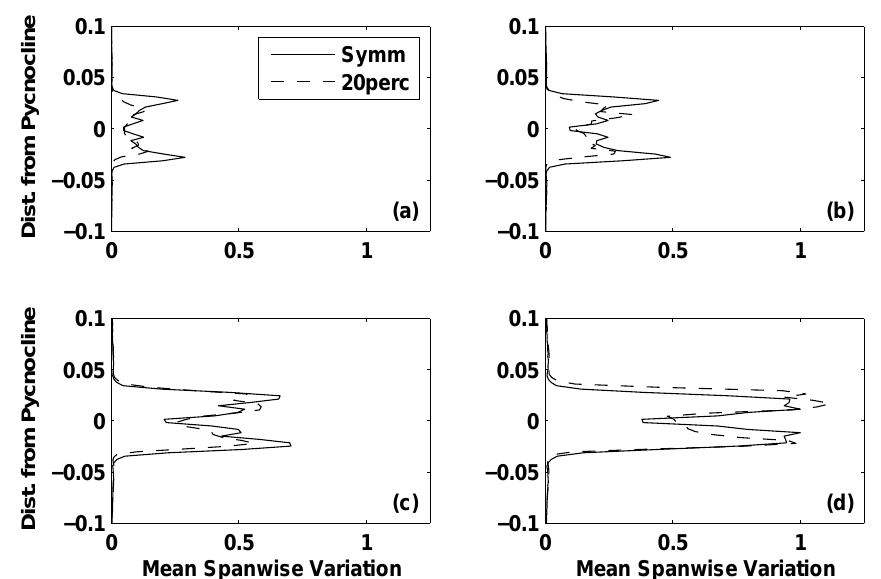
Fig. 10. Plot of the streamwise average of the standard deviation in the spanwise direction of the kinetic energy at t = { 33 . 75s (a) , 35s (b) , 36.25 (c) , 37.5s (d) } . The z-axis has been shifted for the asymmetric case so that both pycnocline centres are at 0. The fields were normalized by the maximum value of the symmetric case at t = 37 . 5s.